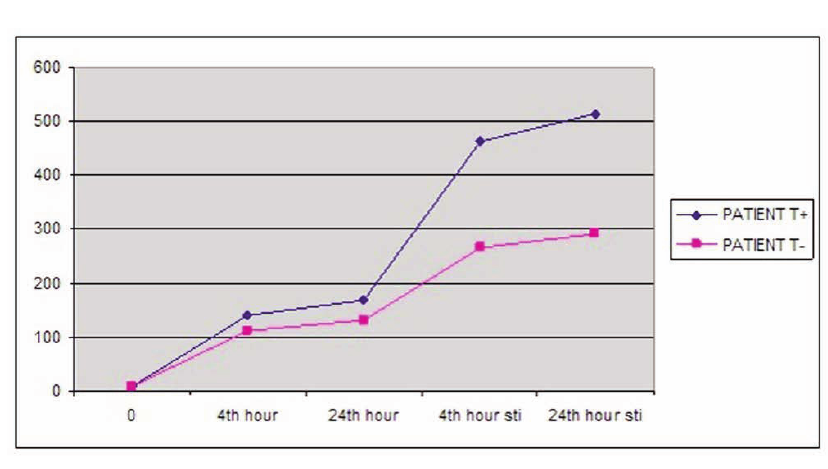
Figure 1. Spontaneous and stimulated levels of IL-1 β in patients and in controls, both carry T allele (pg/mL). Sti, stimulated; T+, T allele carriage.